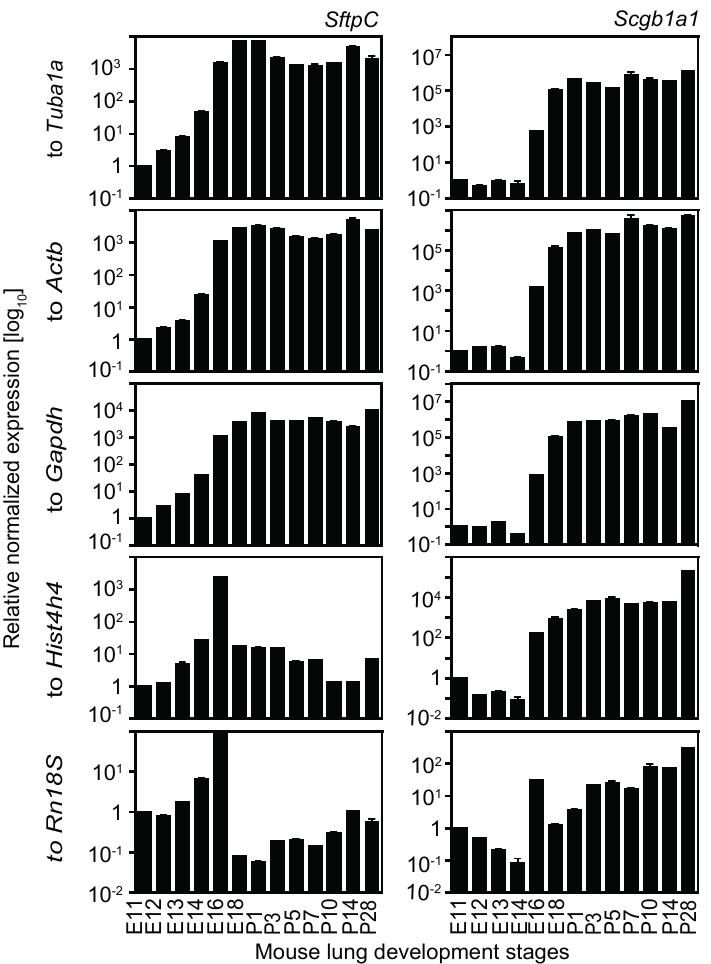
Figure 6. Expression analysis of two cell lineage markers during mouse lung development using different reference genes for normalization. Expression of surfactant protein C ( SftpC , left ) and Clara cell-specific 10 kDA protein ( Scgb1a1 , right ) was analysed during lung development by qRT-PCR. Expression analysis in all stages of lung development was normalized to each of the five reference genes, Tuba1a , Actb , Gapdh , Hist4h4 , and Rn18S. Days post coitum , E ; postnatal, P . Data are represented as mean ± SD; n =